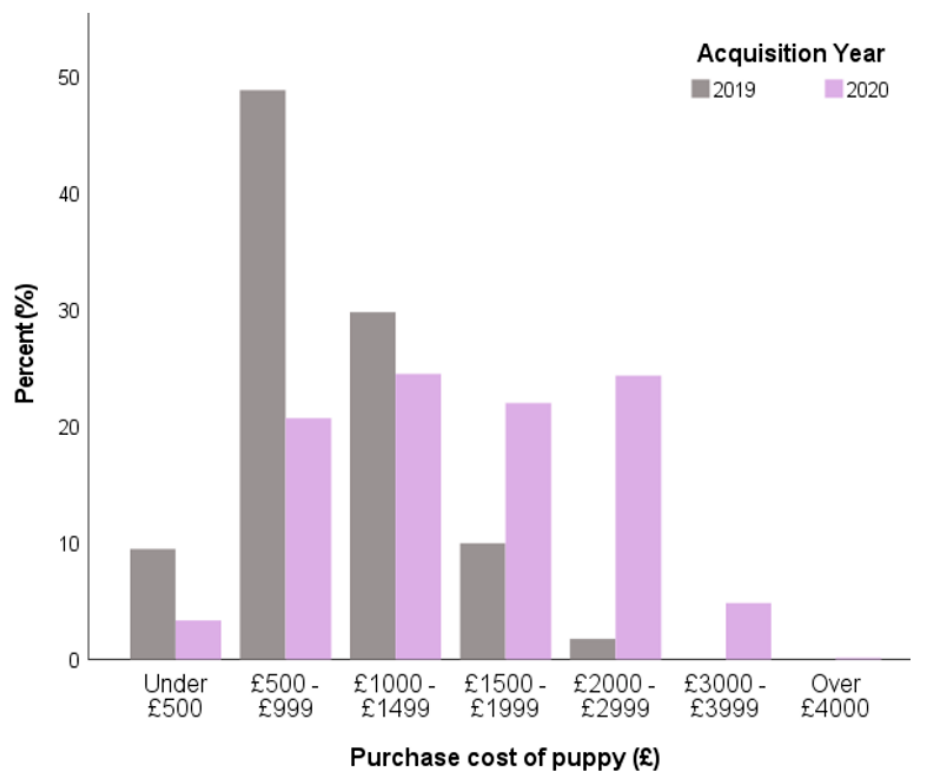
Figure 7. Purchase price of puppies, excluding any associated purchases such as food, collar, bowls, etc., with comparison between 2019 owners ( n = 1022) and Pandemic Puppy owners ( n = 3835) in the UK.